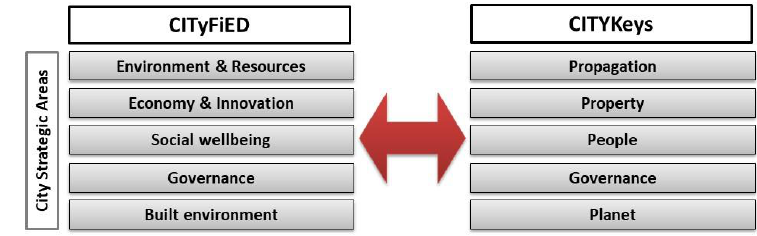
Figure 3. CITyFiED and CITYKeys Strategic Areas [ Error! Reference source not found. ].